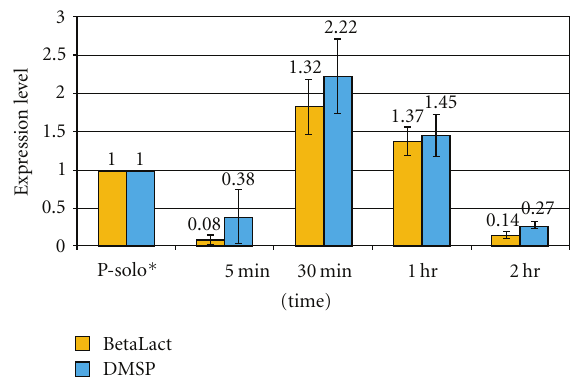
Figure 2: R. denitrificans BetaLact and DMSP gene expression in R. denitrificans-P. aeruginosa dual co-culture. Methods were as described in Figure 1 except for the fourth time point added at one hour.